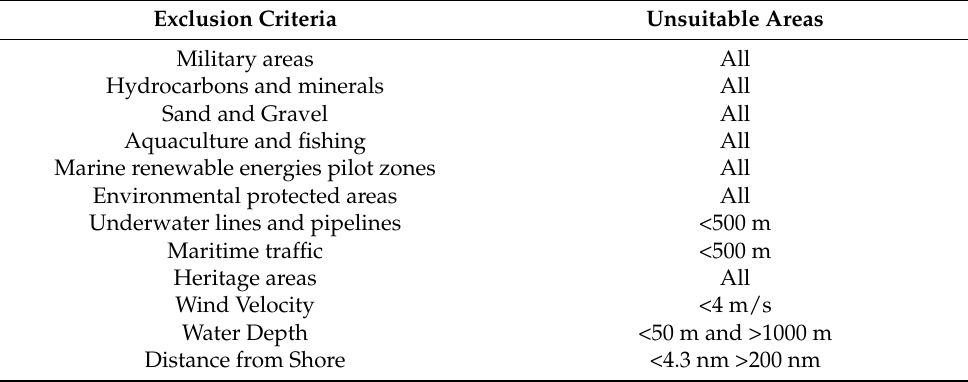
Table 1. Main exclusion